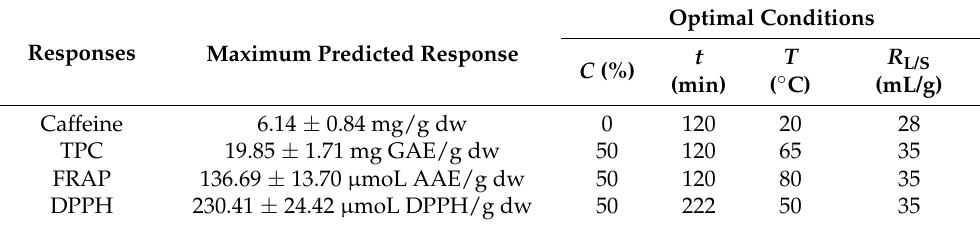
Table 4. Maximum predicted responses and optimum extraction conditions for caffeine, total polyphe- nol content (TPC), and antioxidants using hydroethanolic